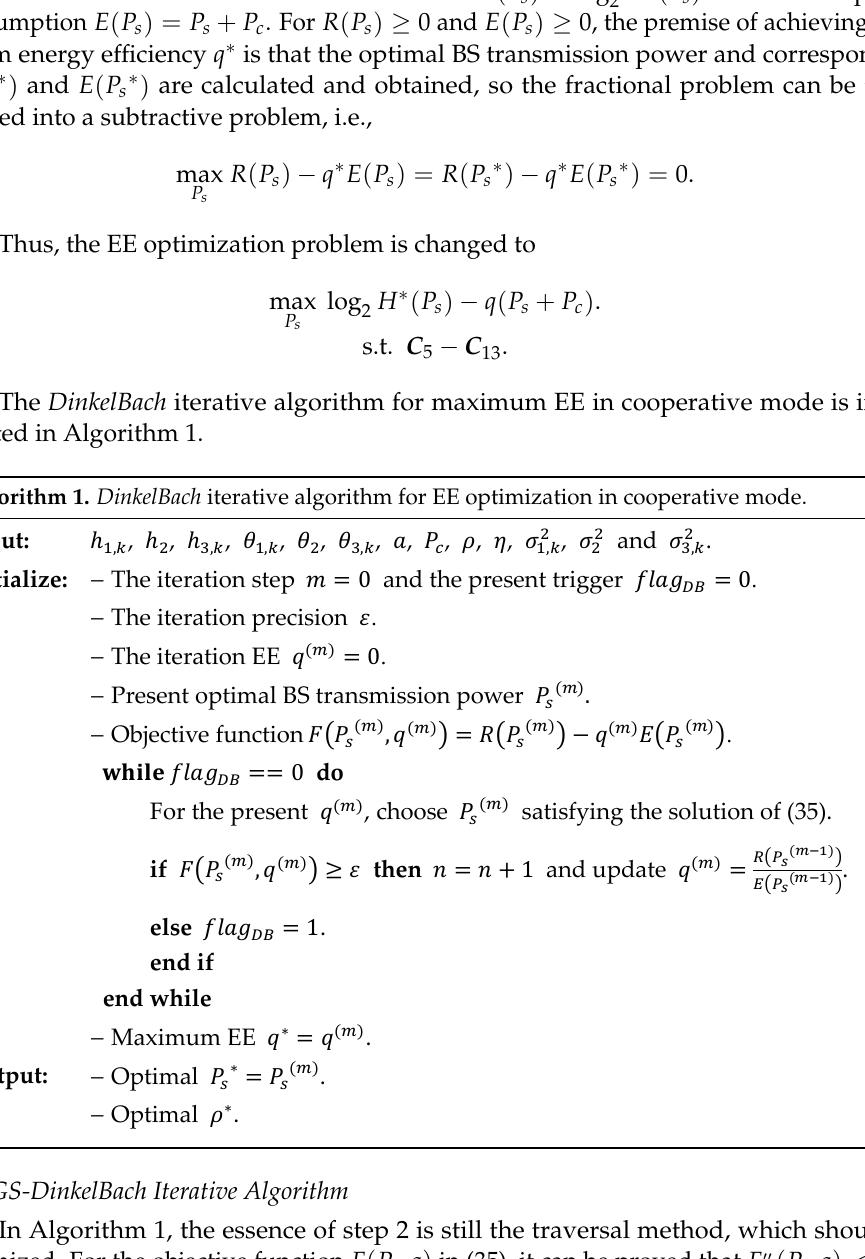
Sensors 2021 , 21 , 5720 10 of 19